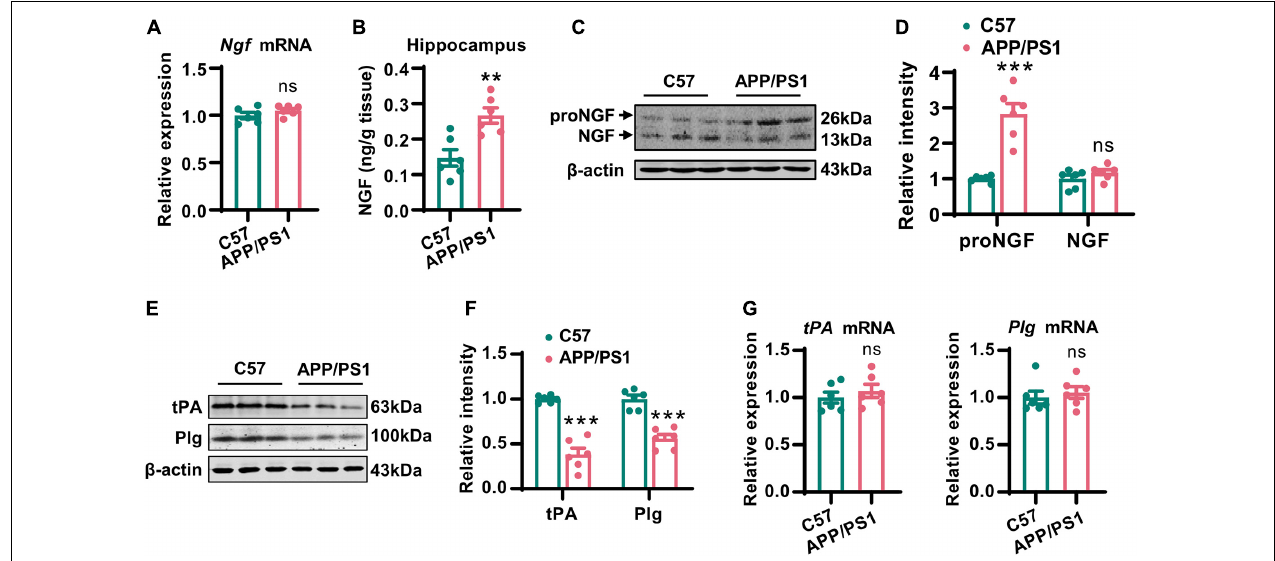
FIGURE 3 | Disturbance of the proNGF/NGF ratio in AD mice was caused by the reduction of tPA and plasmin. (A) The NGF mRNA in hippocampi of 12-months-old APP/PS1 mice and C57 mice was examined by Q-PCR. Unpaired two-tailed Student’s t -test, n = 6 mice for each group; ns, no significance. (B) The total NGF in hippocampi of 12-months-old APP/PS1 mice and C57 mice was measured by an ELISA kit. Unpaired two-tailed Student’s t -test, n = 6 mice for each group, ** p < 0.01. (C,D) The protein level of mature NGF in the hippocampi of 12-months-old APP/PS1 mice and C57 mice was detected by western blotting. The representative images were shown in (C) , and quantitative analysis was shown in (D) . Multiple t -test adjusted with the Holm-Šidák method, n = 6 mice for each group, *** p < 0.001. (E,F) The protein levels of tPA and plasminogen (Plg) were examined in the hippocampi of 12-months-old APP/PS1 mice and C57 mice. The representative images were shown in (E) , and quantitative analysis was shown in (F) . Multiple t -test adjusted with the Holm–Šidák method, n = 6 for each group, *** p < 0.001. (G) The mRNA levels of tPA and Plg in the hippocampi of 12-months-old APP/PS1 mice and C57 mice were examined by Q-PCR. Unpaired two-tailed Student’s t -test, n = 6 mice for each group; ns, no